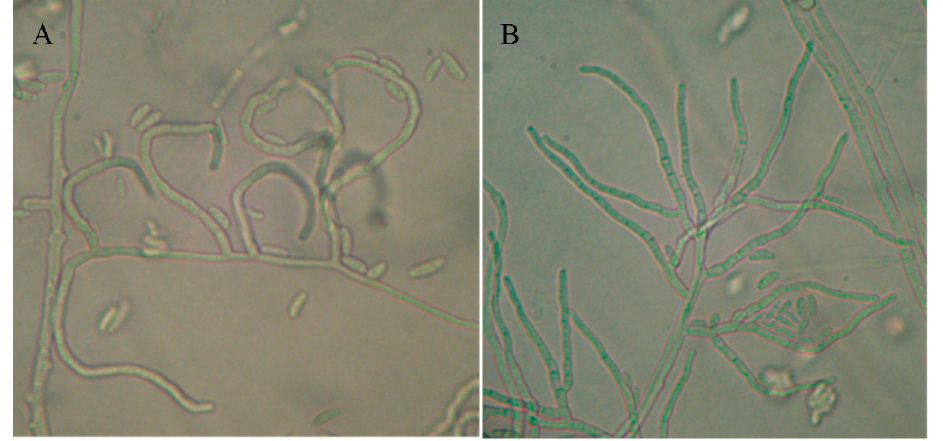
Figure 1. ( A ) An example of Fusarium circinatum coiled sterile hyphae ( B ) An example of F. circinatum sterile hyphae not distinctively coiled.